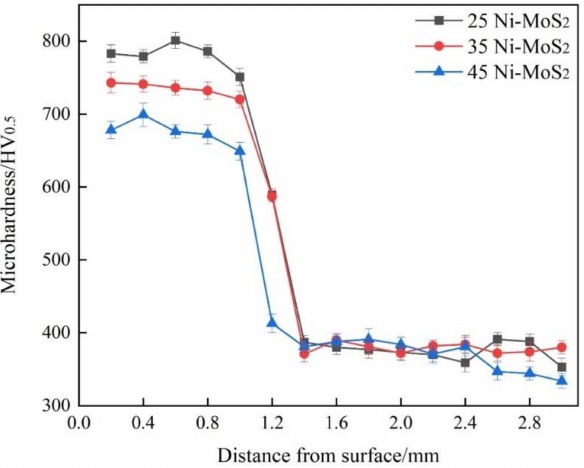
Figure 11. The microhardness of the